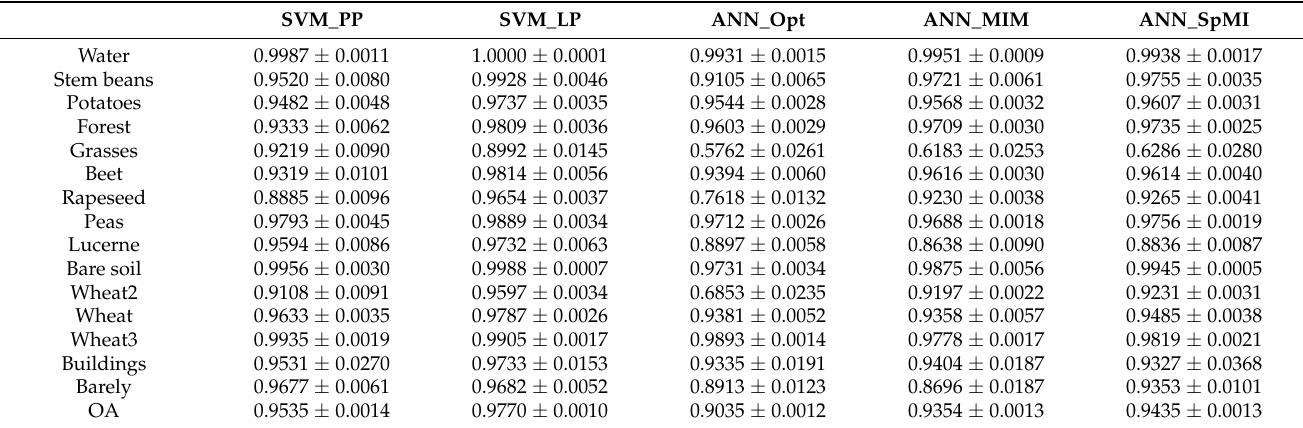
Table 14. The objective indicators of three ANN-based classifiers and two SVM classifiers on different forms of parameters of Touzi decomposition for the Flevoland image.